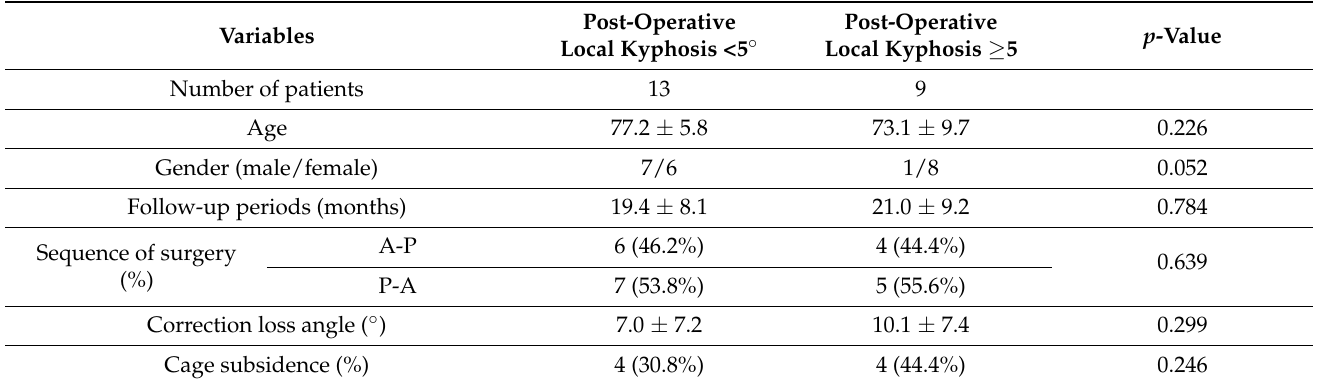
Table 4. Comparison between patients with a postoperative local kyphotic angle of less than 5 degrees and those with 5 degrees or more in the 5 vertebrae fixation group (5VG) and the 4 or less vertebrae fixation group